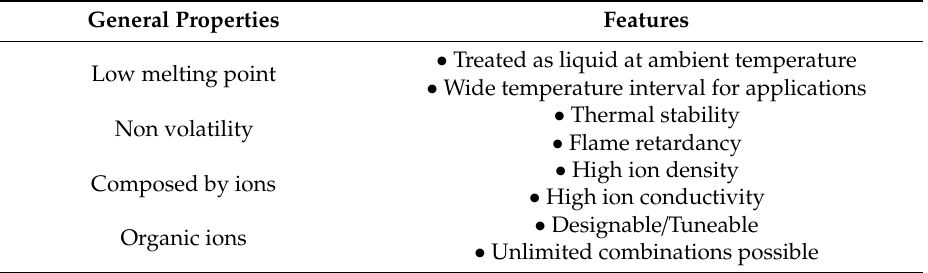
Table 1. General characteristics of room temperature ionic liquids [7].